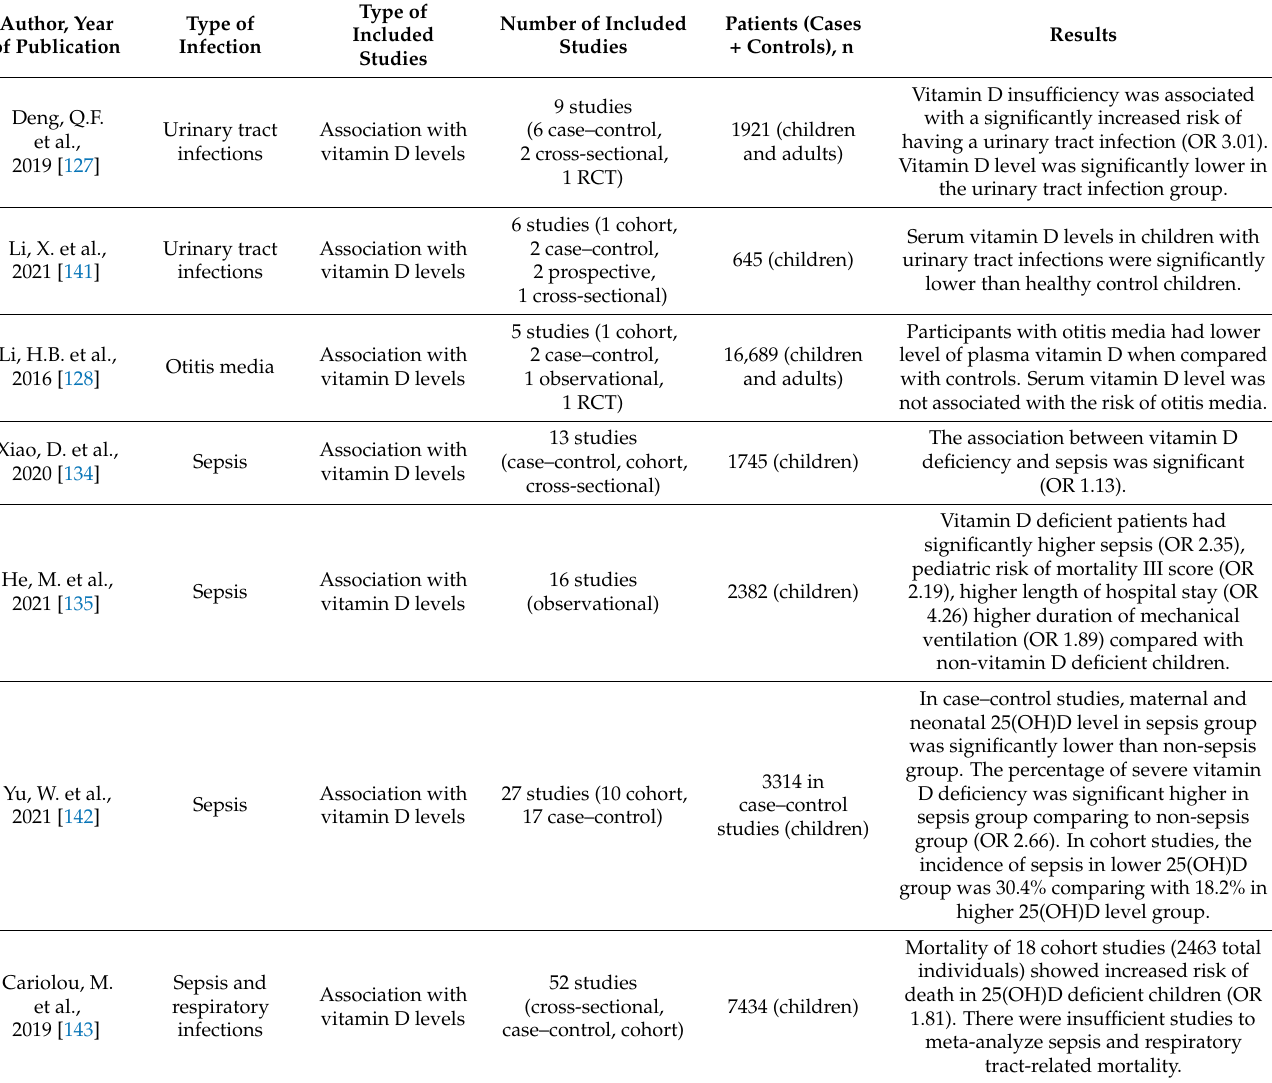
Table 4. Meta-analyses that evaluated the association between vitamin D and infections in